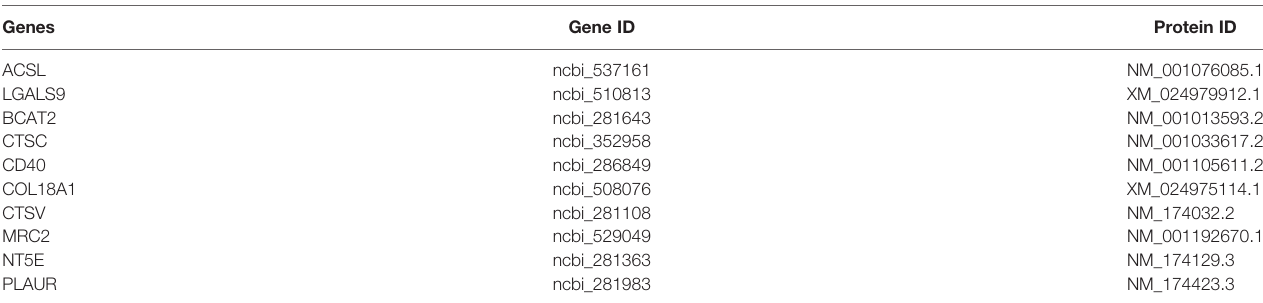
TABLE 2 | Ten genes were signi fi cantly differentially expressed both in mRNA and proteins levels. Genes Gene ID Protein ID